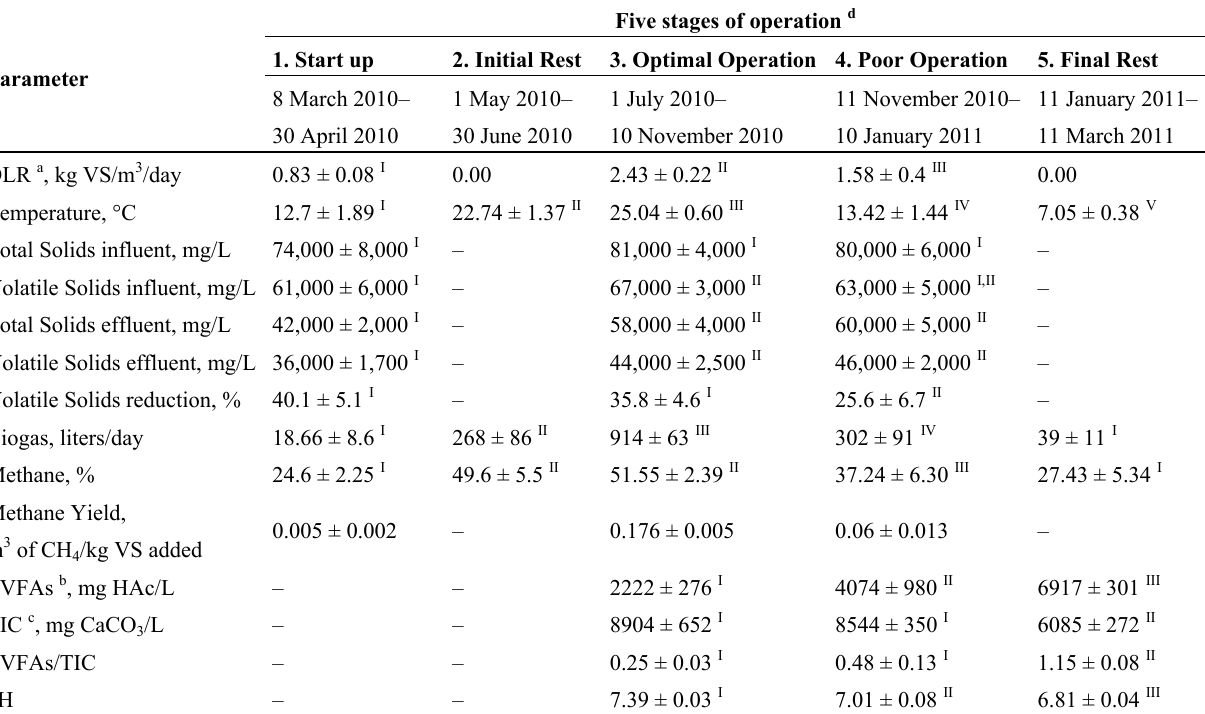
Table 1. Main operational variables during the five stages of digester operation. (95% confidence intervals, ). Statistical differences of operational data among